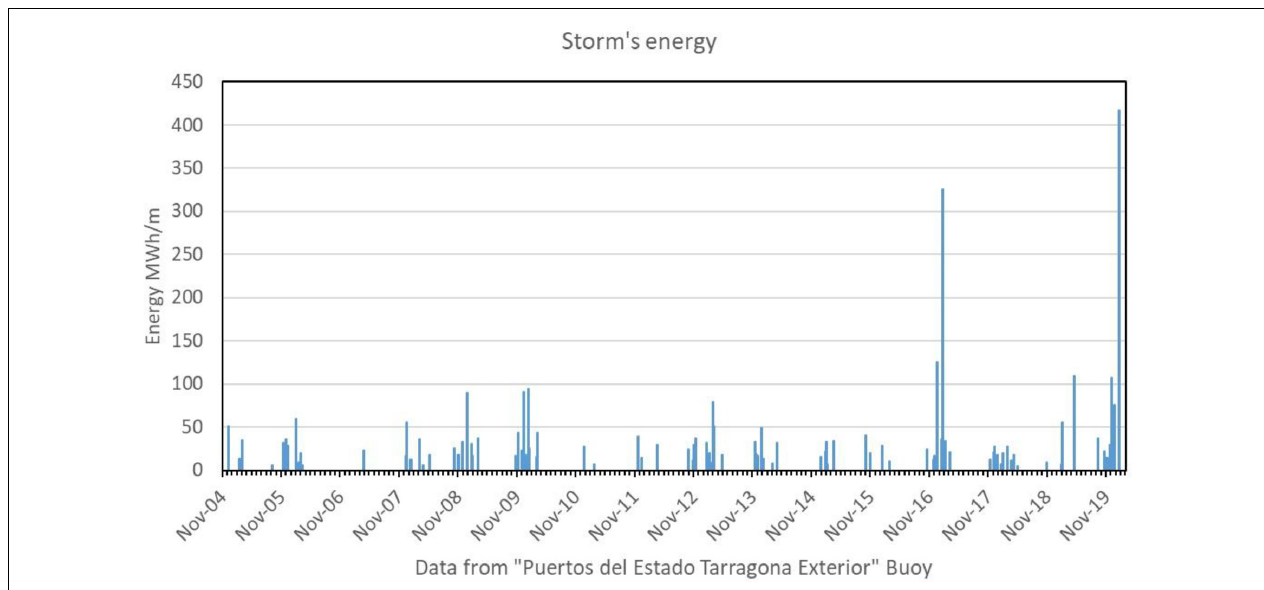
FIGURE 4 | Time series of integrated wave storm energetic contents, where storm events are defined with respect to a 2.5 m threshold for the significant wave height. The plot corresponds to wave buoy recorded data at the Tarragona deep water buoy (depth of 688 m) and it shows the Gloria peak (January 2020) and the January 2017 peak, as very energetic events in the last 3